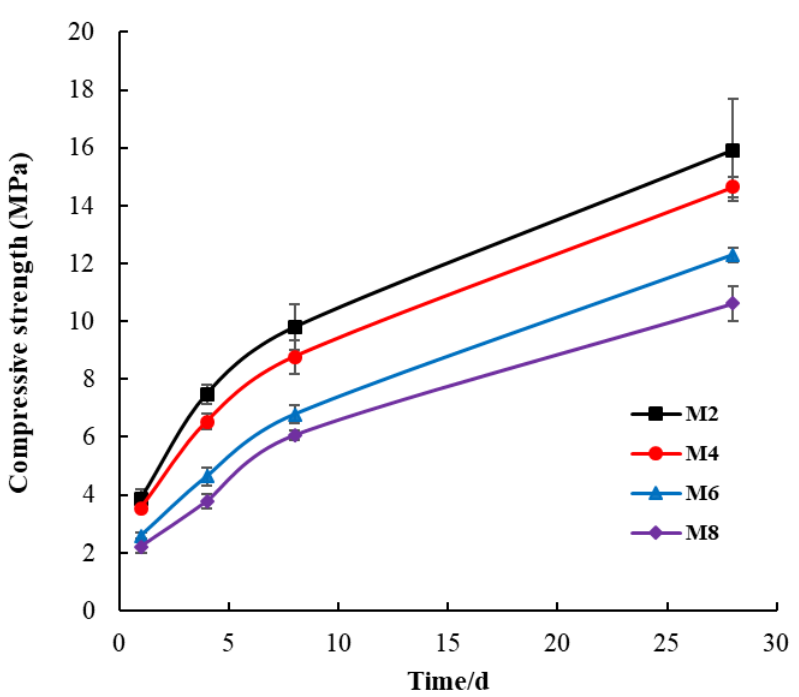
Figure 1. Compressive strength of the silt artificial reef (SAR) specimens.